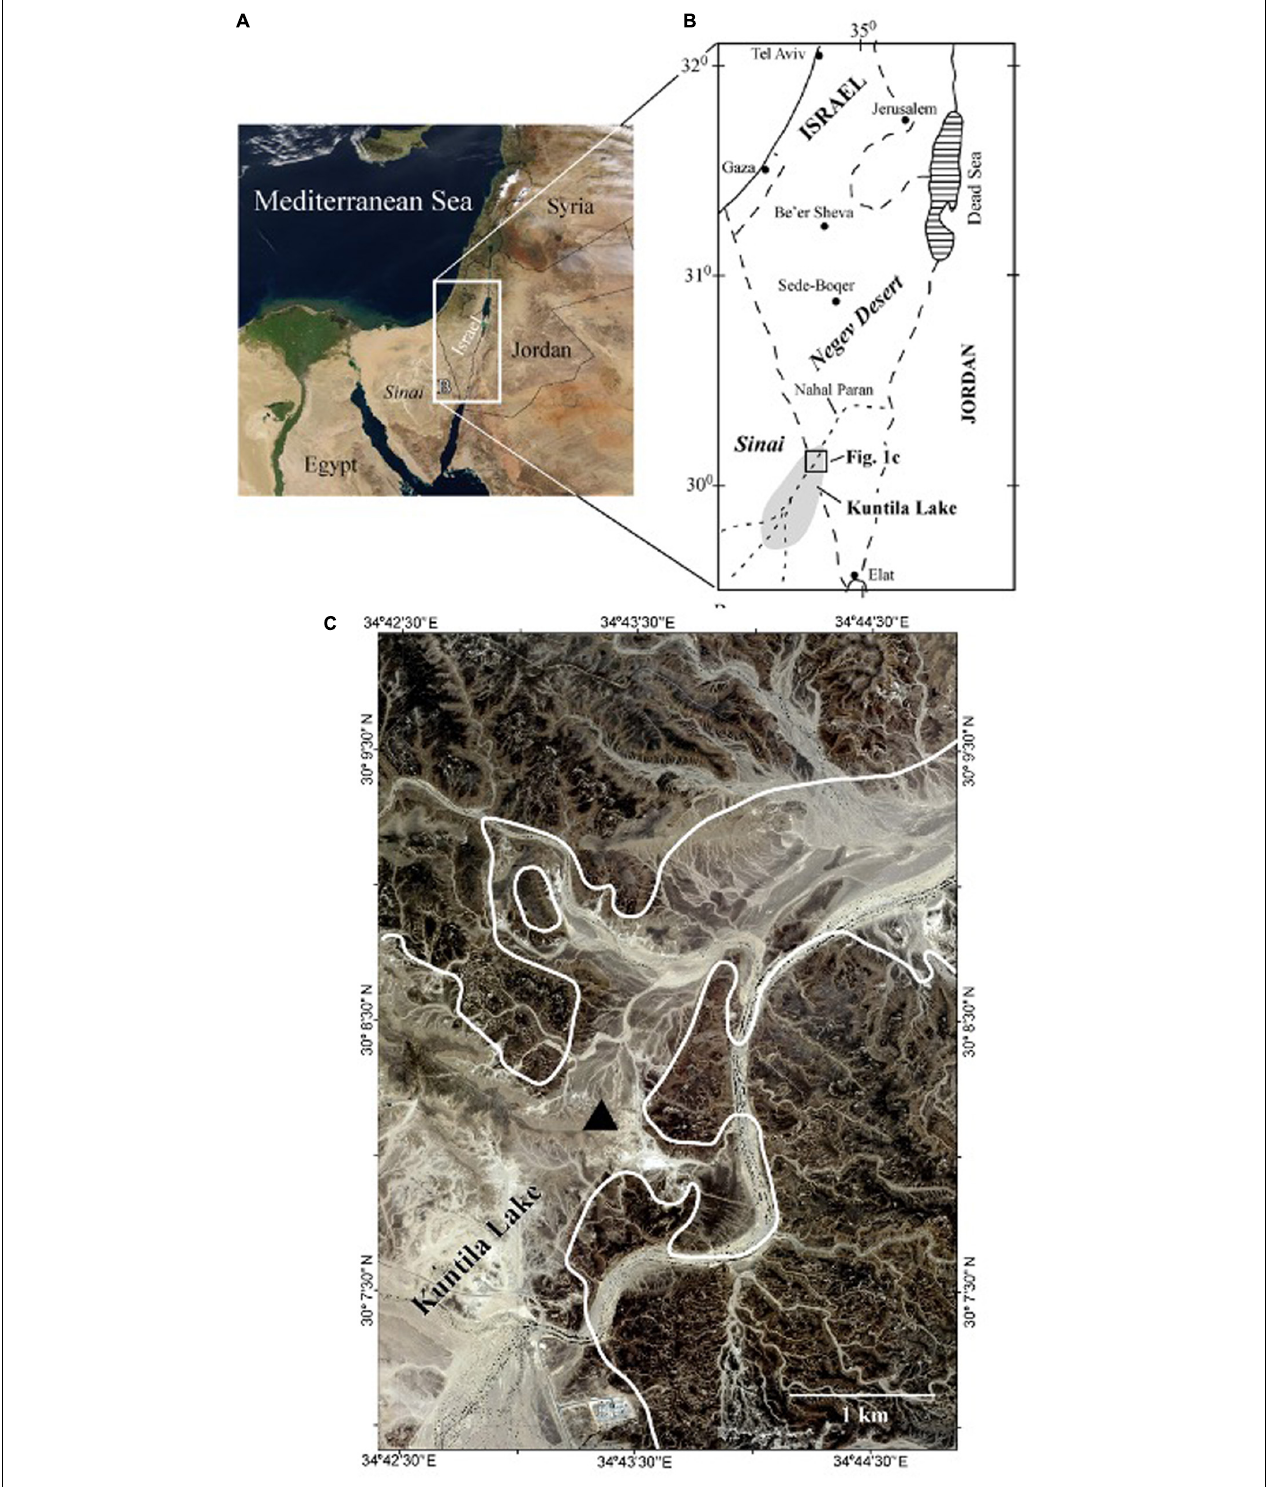
FIGURE 1 | (A) Satellite image showing the location of the Sinai Peninsula at the biogeographic bridge between Africa and Eurasia. The white rectangle is enlarged in (B) and depicts a sketch map of southern Israel with the inferred extension of the Kuntila Lake. (C) Satellite image of the Nahal Paran basin in the southern Negev Desert, with location of the Kuntila Gate section (black triangle). The thick white line delineates the outcrops of the Kuntila lacustrine sediments within the Arava Formation in the area.